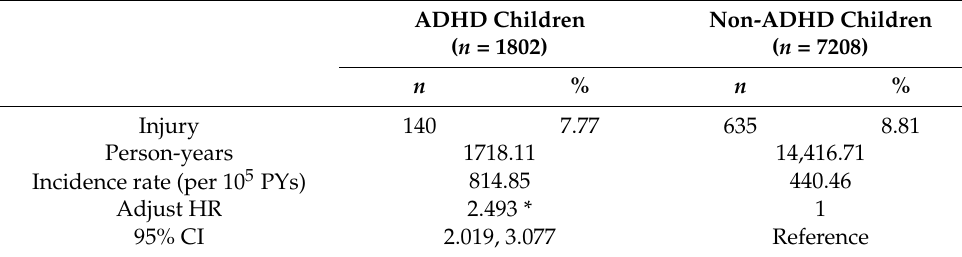
Table 6. Incidence rate and adjust HR for injury among the hospitalized child at the end of follow-up. ADHD